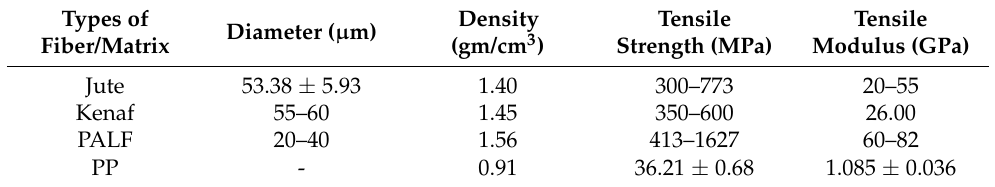
Table 2. Physical and mechanical properties of jute fiber, kenaf fiber, PALF, and PP.